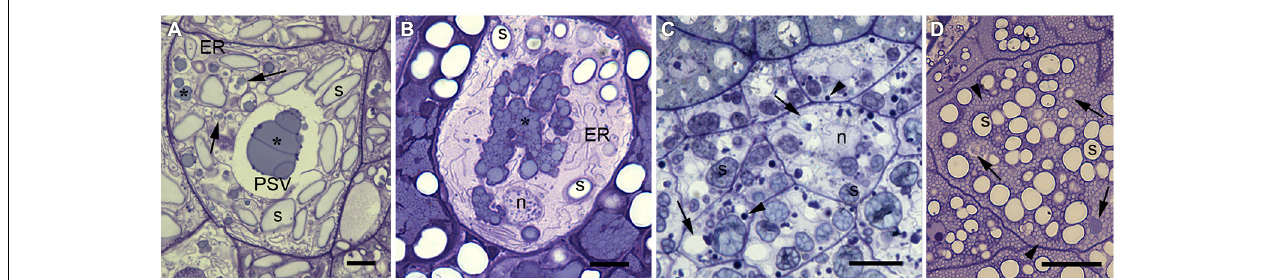
FIGURE 1 | Comparison of endosperm cells from the subaleurone layer at mid-maturation stage in wheat (A), barley (B), rice (C), and maize (D). Semithin sections (1 μ m in thickness), stained with toluidine blue for light microscopy (Arcalis etal., 2004). (A) Wheat endosperm cells show a predominant, large central PSV. Note the huge prolamin aggregates stained in light blue (*) and the scarce globulin (triticin) bodies stained in dark blue at the periphery of the prolamins. Several smaller vacuolar compartments containing prolamins can also be observed (arrows), and well developed endoplasmic reticulum (ER) and abundant spindle like starch grains (s). (B) Barley endosperm cells show abundant protein deposits forming a multiphasic protein body (see the different shades of blue), habitually within a PSV. Note